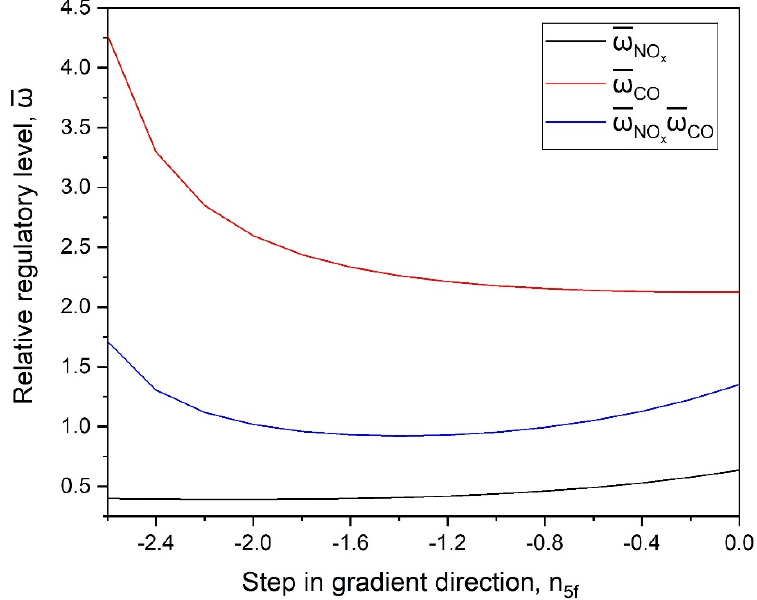
Figure 7. Relative regulatory level based on step in gradient direction for five factors.